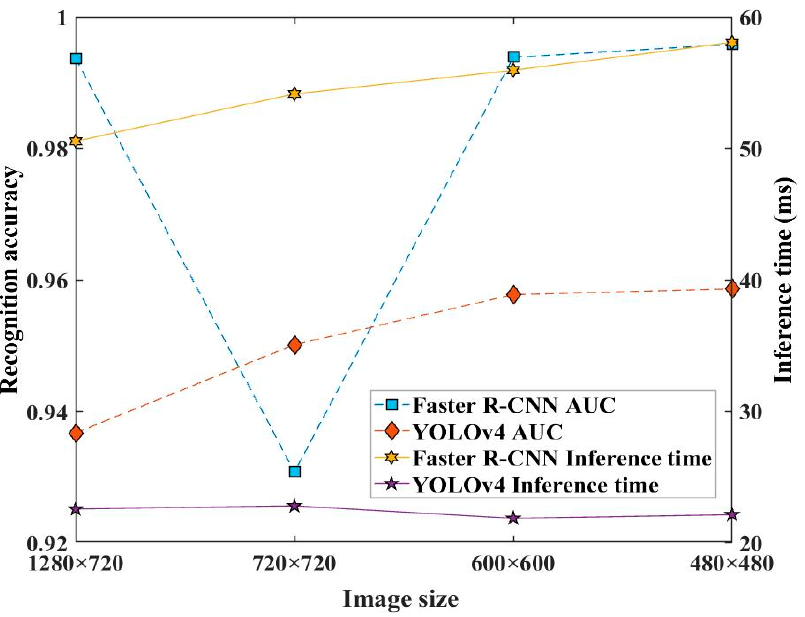
Figure 13. Effect of image size of developing datasets on the recognition accuracy and inference time of the two approach models.